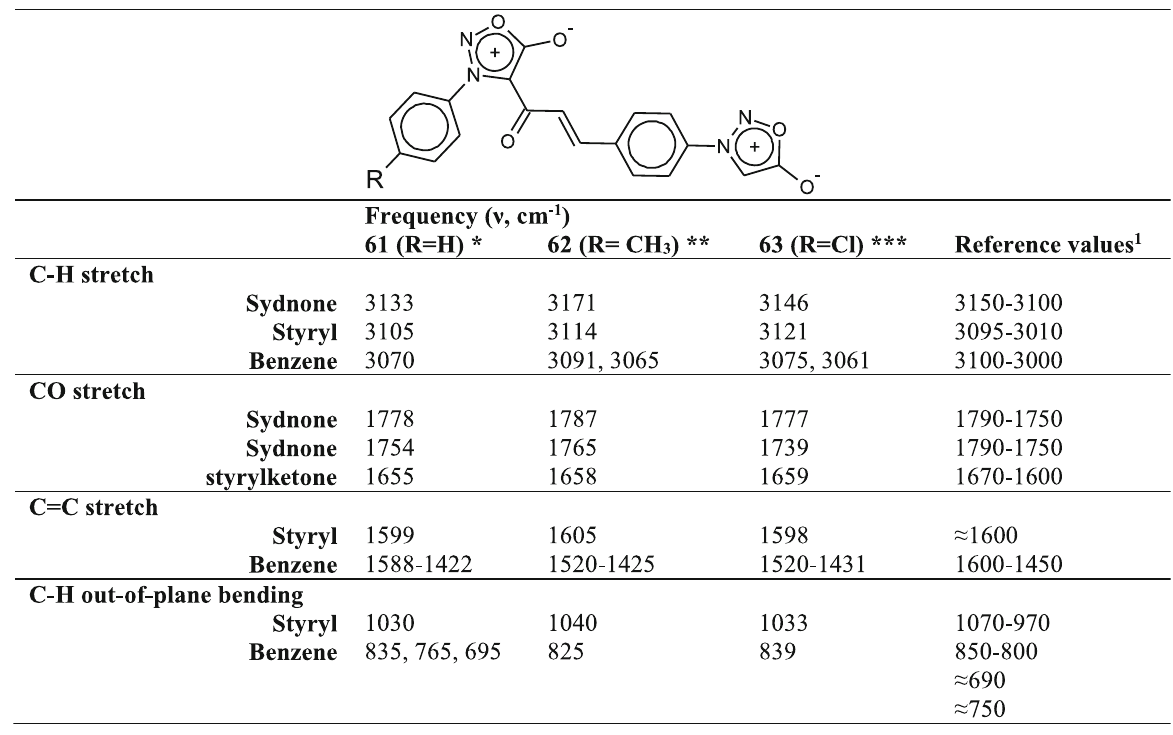
Table 5 FTIR spectral data of compounds 61 –